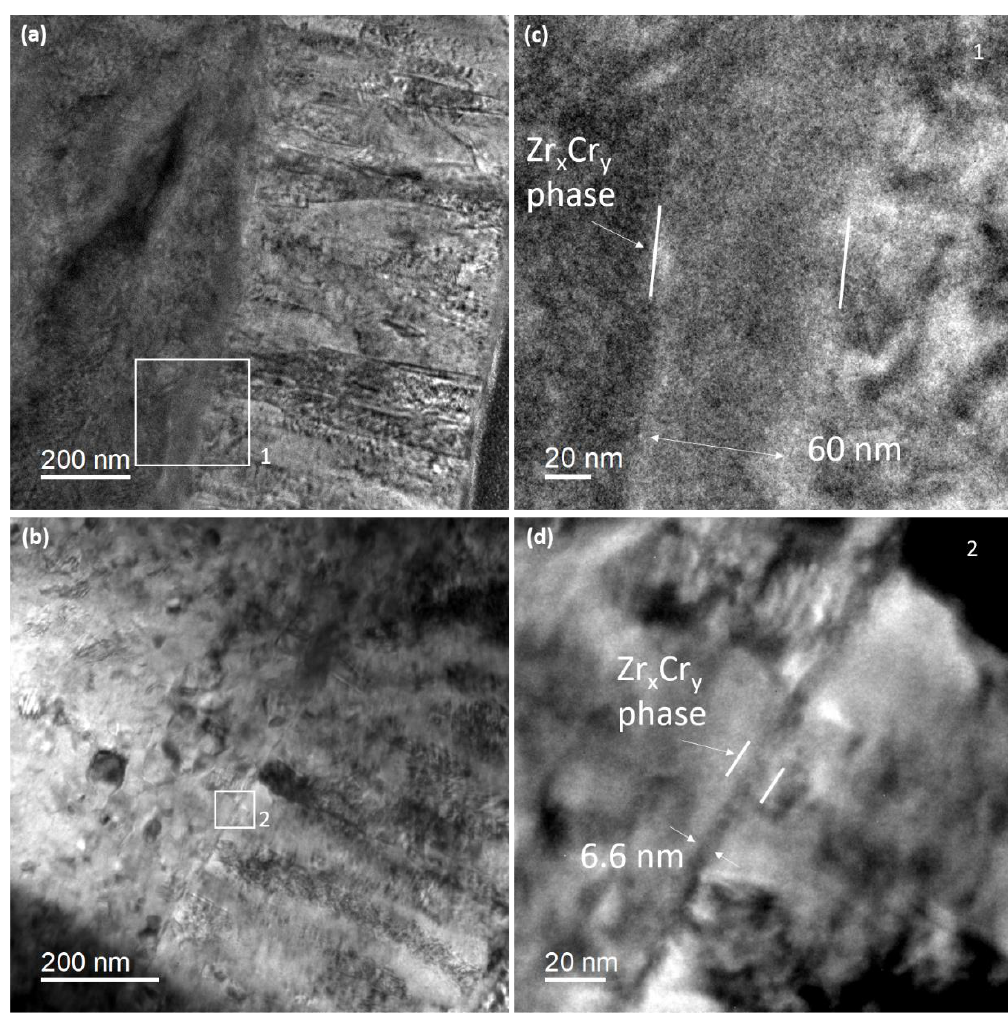
Figure 5. The interface region before and after irradiation: ( a ) bright field TEM image of the Zr-Cr interface, ( b ) same area after ion-irradiation, ( c ) detailed view of the interface corresponding to the white rectangle labeled 1 in ( a ), ( d ) detailed view of the interface after irradiation corresponding to the white rectangle labeled 2 in ( b ).